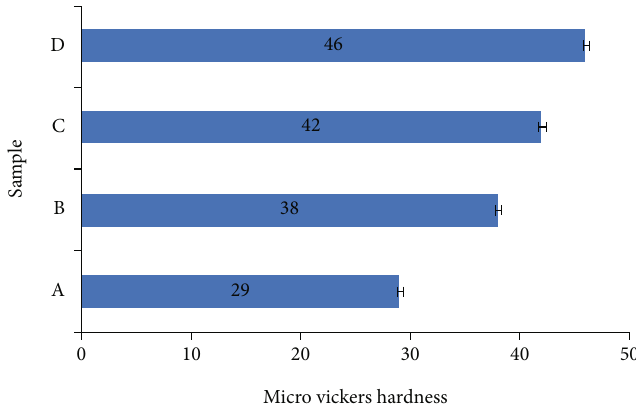
Figure 7: Micro Vickers hardness number of AA6061/Si